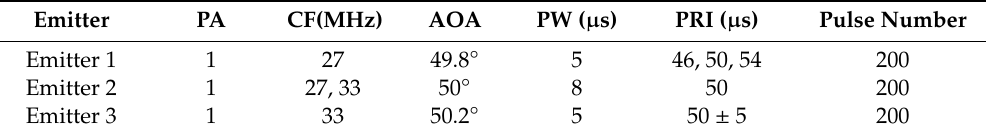
Table 6. Simulation parameters.